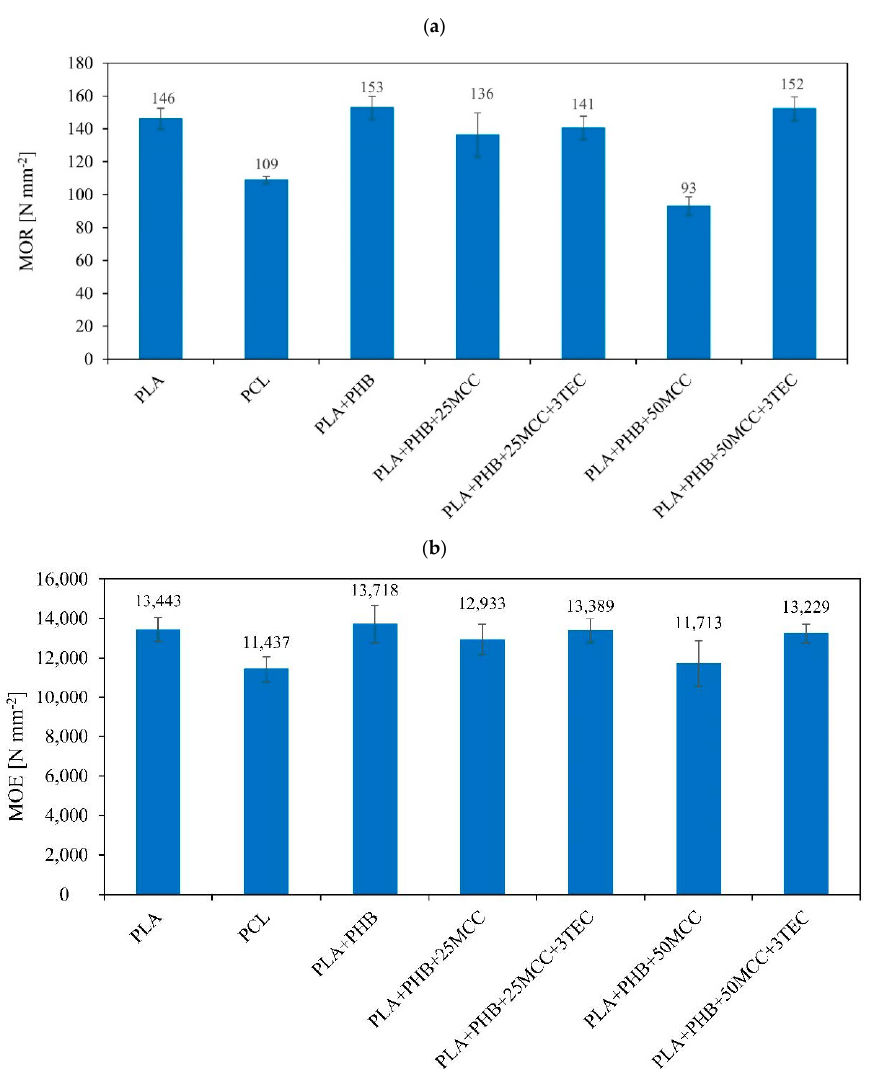
Figure 5. ( a ) Modulus of rupture (MOR) and ( b ) modulus of elasticity (MOE) of the tested five-layer composites.